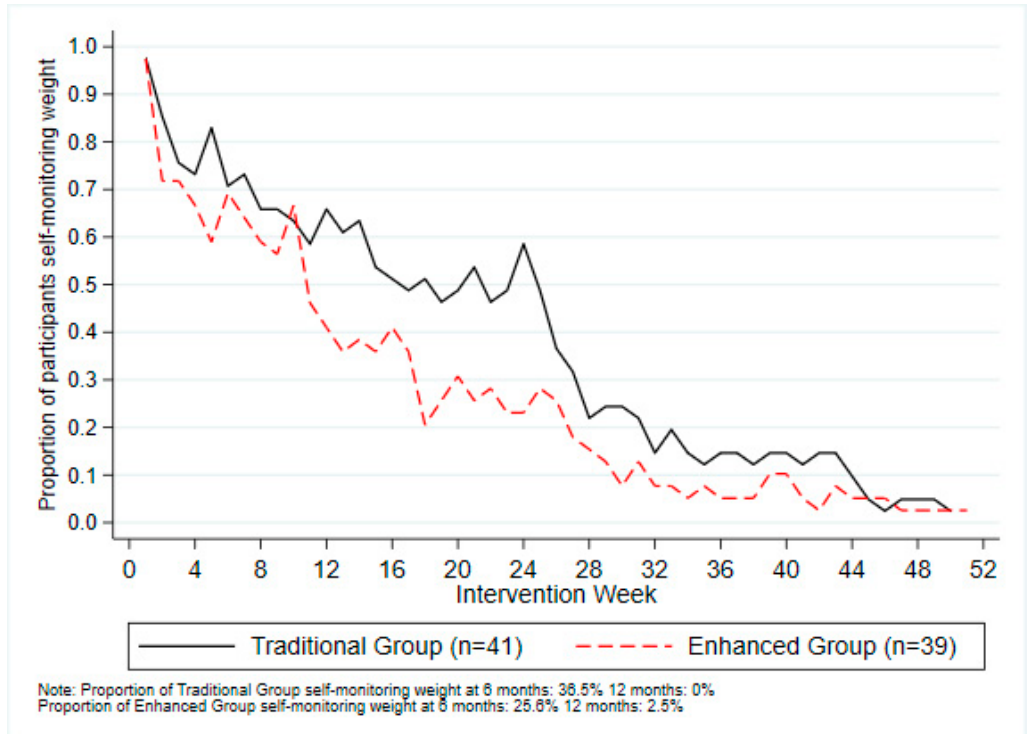
Figure 4. Frequency of weekly self-monitoring of body weight using the Balanced app by intervention Figure 4. participants.